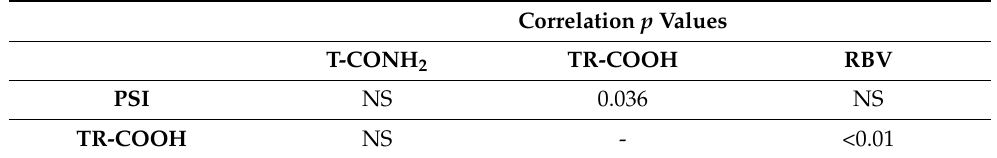
Table 3. Significant p values reported according to Spearman correlations for TW4 patients ( n = 17).